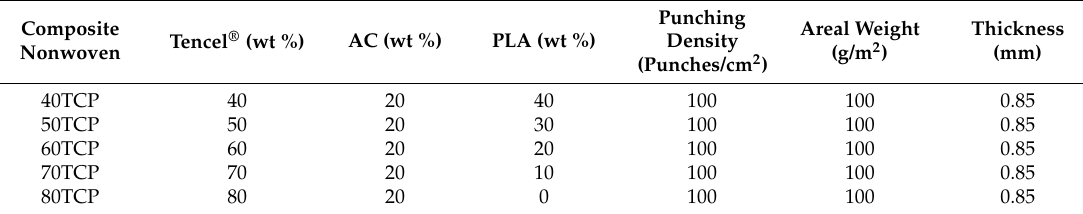
Table 1. Name codes of Tencel ® /Absorbent-Cotton/PLA (TCP) composite nonwoven used for blood